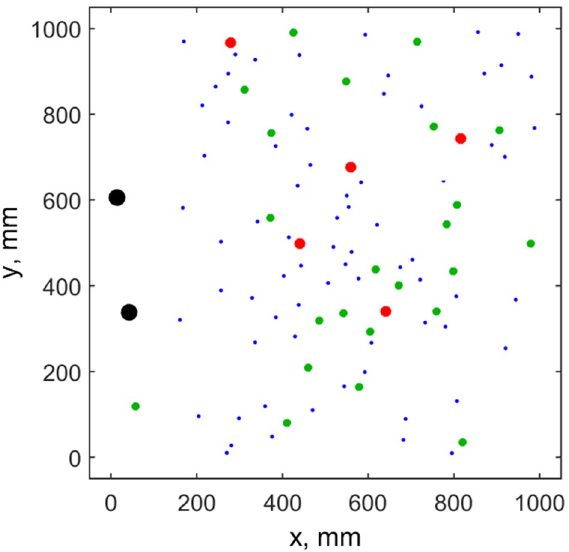
Figure 8. Shifted pattern at the presence of the “wave of fear”. Some food was just deposed inside the depopulated area near to the dangerous boundary. Some small individuals are in the vicinity to the food, while absolute majority of the population is localized in a center or near opposite boundary. The symbols have the same meaning as in Fig. 1.